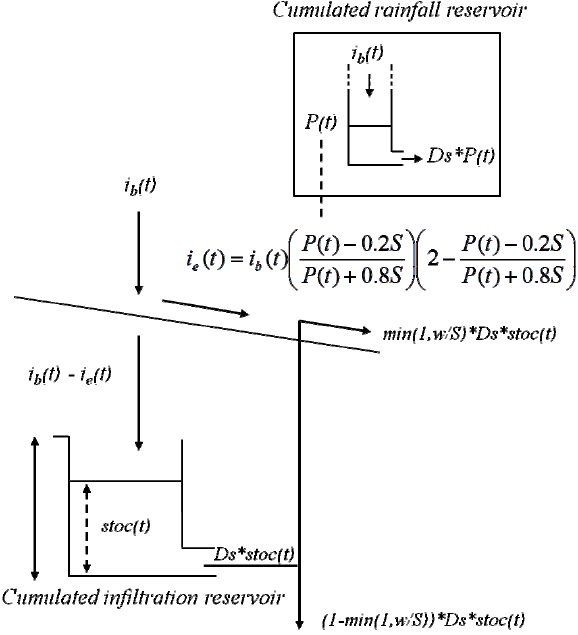
Figure 1: Runoff model for each mesh of the basin Fig. 1. Runoff model operating for each mesh of the